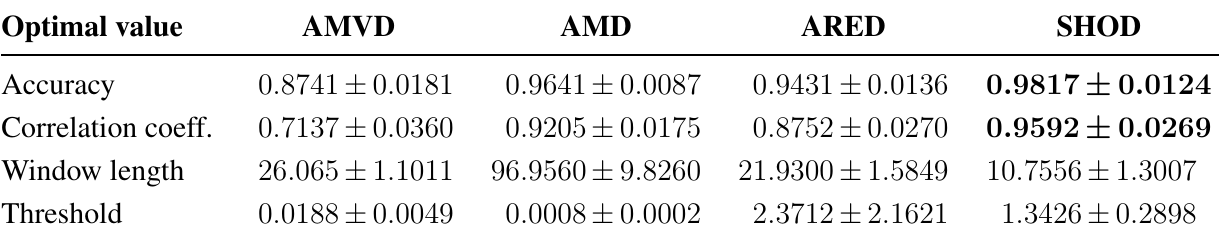
Table 1. Results of the Monte Carlo simulation ( N = 500 ). Synthesized signals. Average Accuracy, Correlation coefficient and associated parameters (Magnitude methods without flexible input).